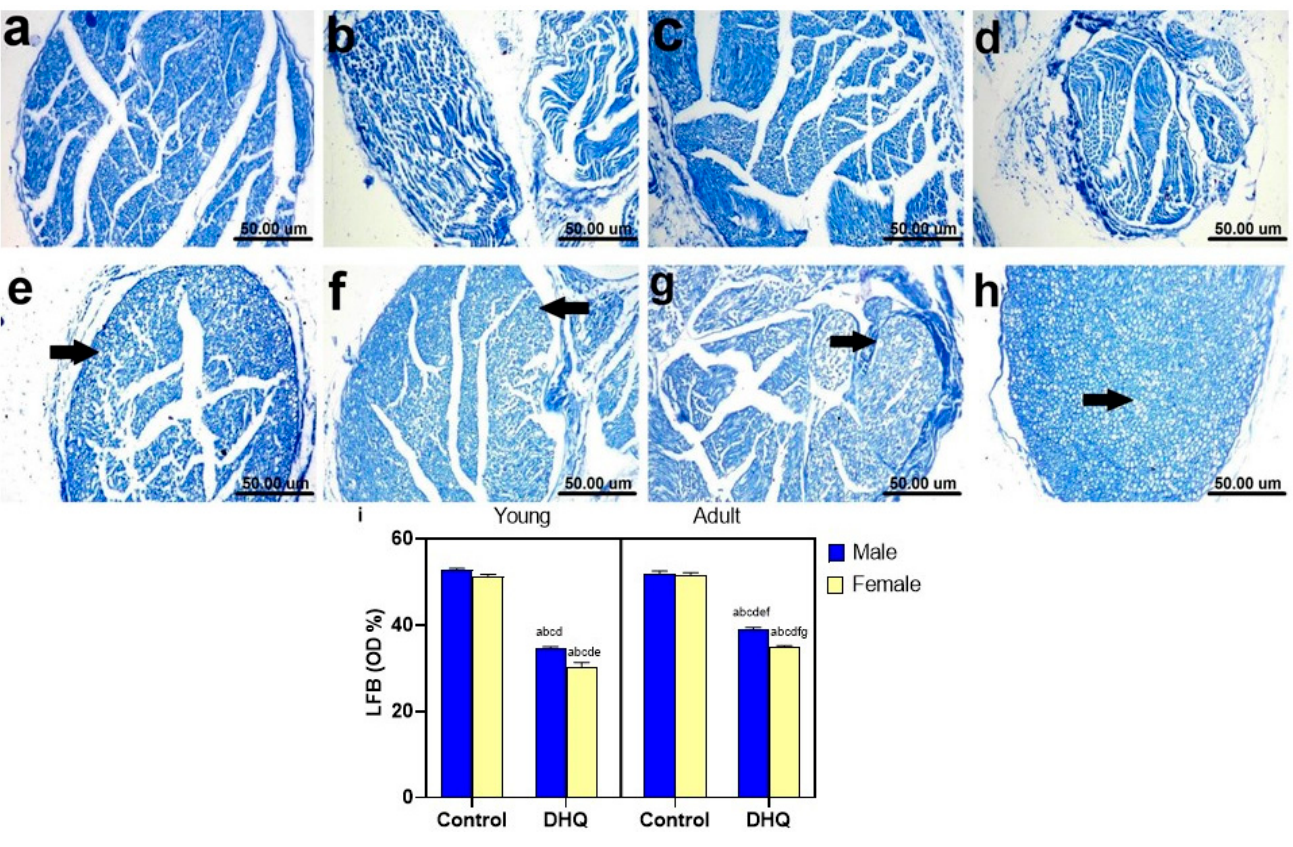
Figure 11. Histological Luxol fast blue-stained sections from sciatic nerves of ( a – d ) control rats, ( a ) young male, ( b ) young female, ( c ) adult male, and ( d ) adult female, showing apparently normal dark blue myelinated axons. ( e–h ) showing demyelination of nerve fibers (black arrow), ( e ) DHQ young male, ( f ) DHQ young female, ( g ) DHQ adult male, and ( h ) DHQ adult female. (Scale bar 50 um). ( i ) Quantitative analysis of LFB staining in sections from sciatic nerves. Each bar with a vertical line represents the mean ± S.D. of 5 rats per group (5 fields/rat). a vs. control young male, b vs. control young female, c vs. control adult male, d vs. control adult female, e vs. DHQ young male, f vs. DHQ young female, and g vs. DHQ adult male using three-way ANOVA followed by Tukey’s post hoc test; p < 0.05. DHQ; diiodohydroxyquinoline.